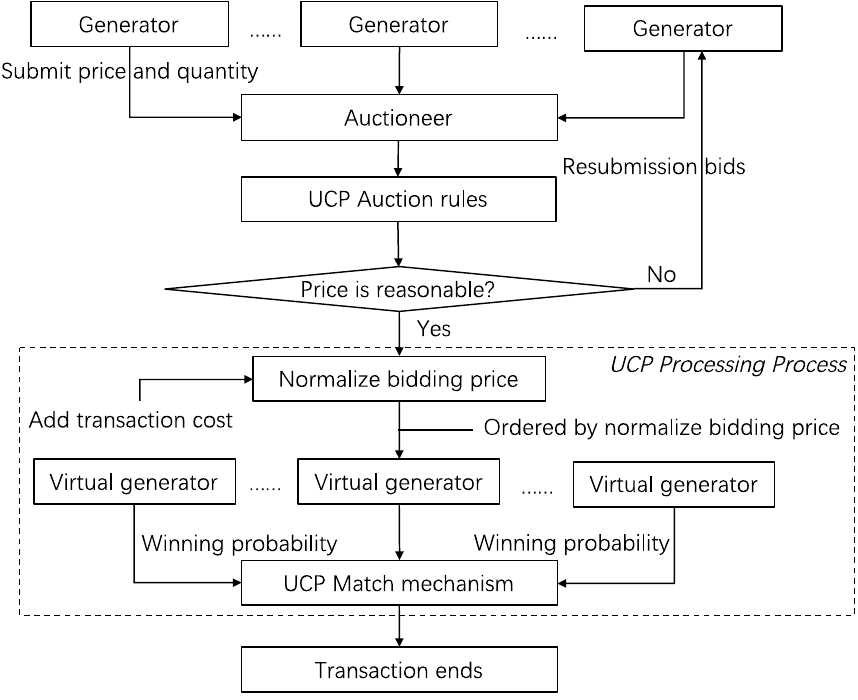
Figure 2. The specific process of the UCP auction.